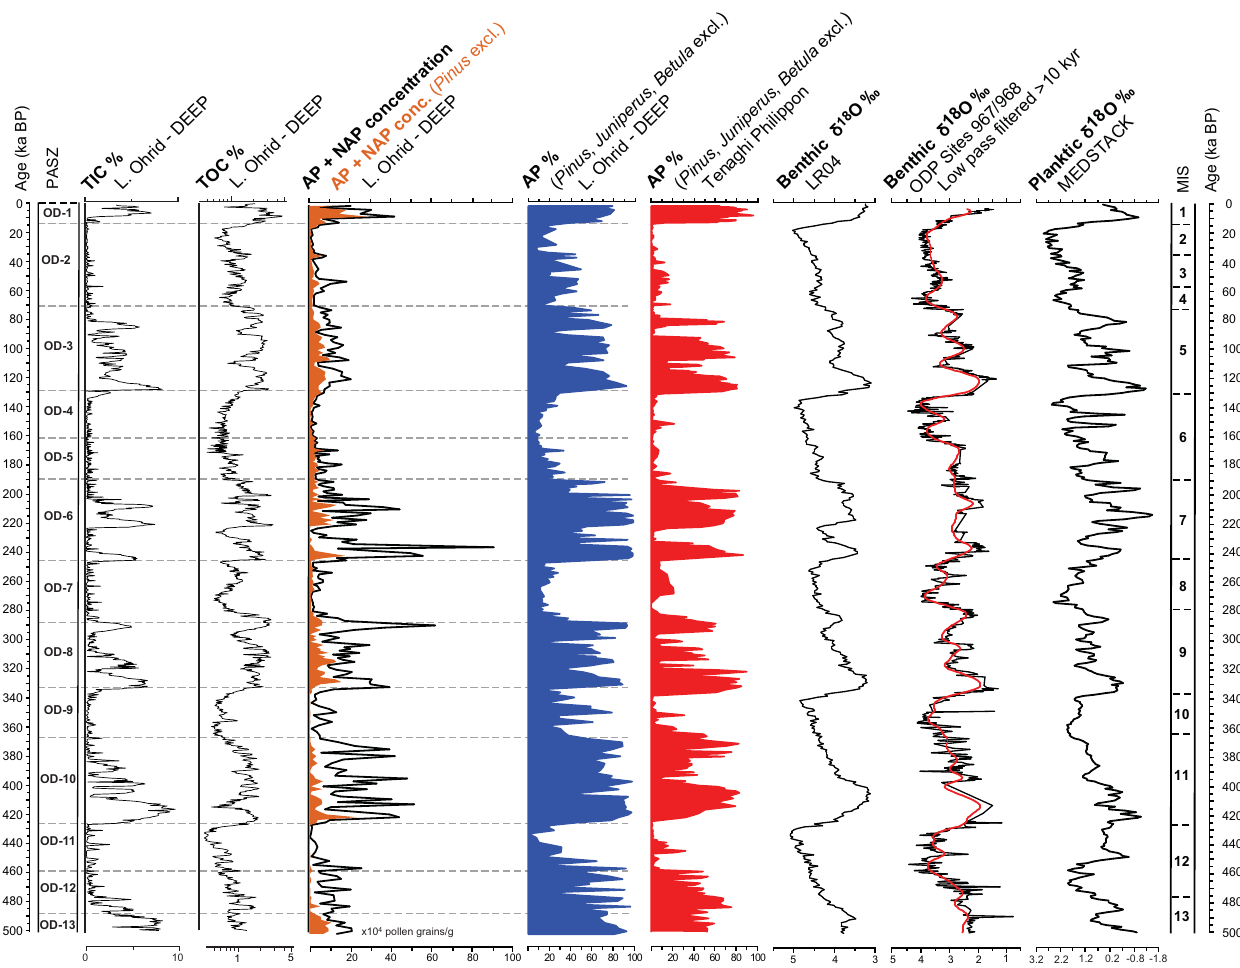
Figure 4. Comparison of selected proxies from Lake Ohrid with other records spanning the last 500ka drawn against original age models. Lake Ohrid: total organic carbon, TOC, total inorganic carbon, TIC (Francke et al., 2016); total pollen concentration of terrestrial plants (AP + NAP) and the same without Pinus , AP percentages (this study). Tenaghi Philippon: AP% excluding Pinus , Betula and Juniperus (Wijmstra, 1969 and Wijmstra and Smit, 1976; age model from Tzedakis et al., 2006). Marine records: LR04 δ 18 O benthic stack (Lisiecki and Raymo, 2005); stacked benthic δ 18 O data for ODP sites 967 and 968 from the eastern Mediterranean (Konijnendijk et al., 2015); MEDSTACK planktic δ 18 O data (Wang et al.,